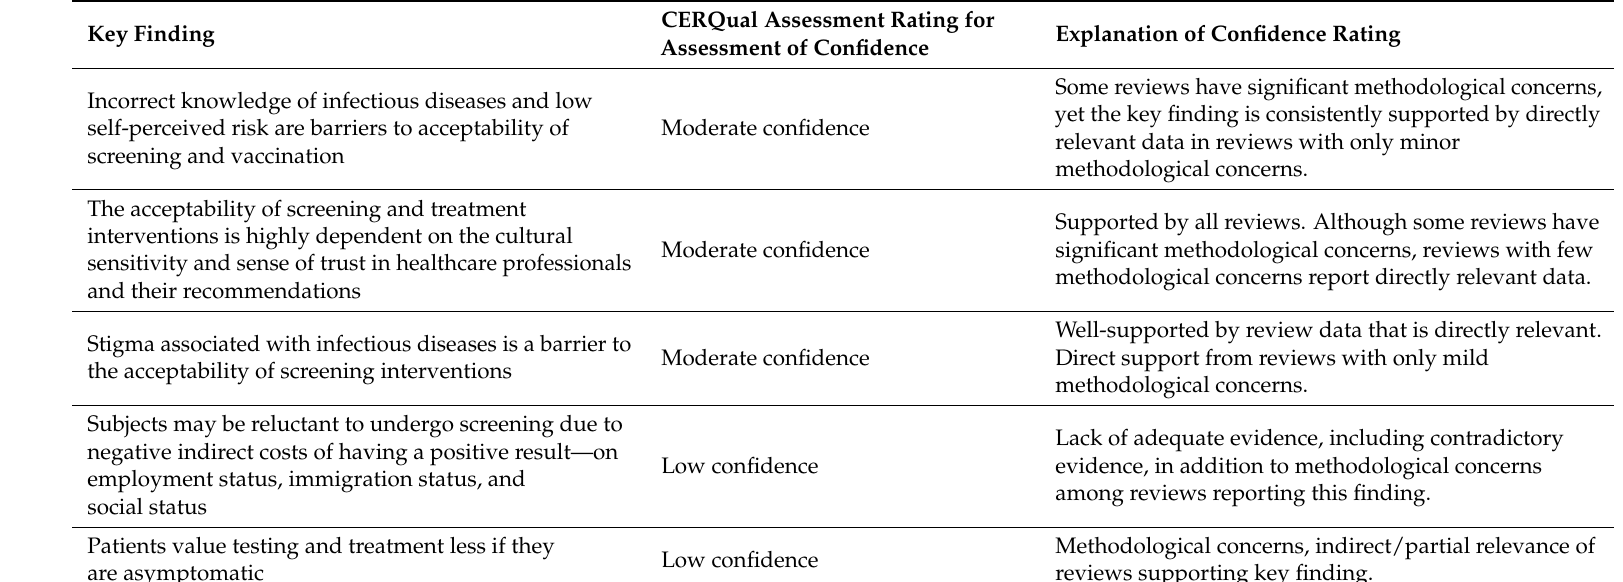
Table 4. Summary CERQual Confidence